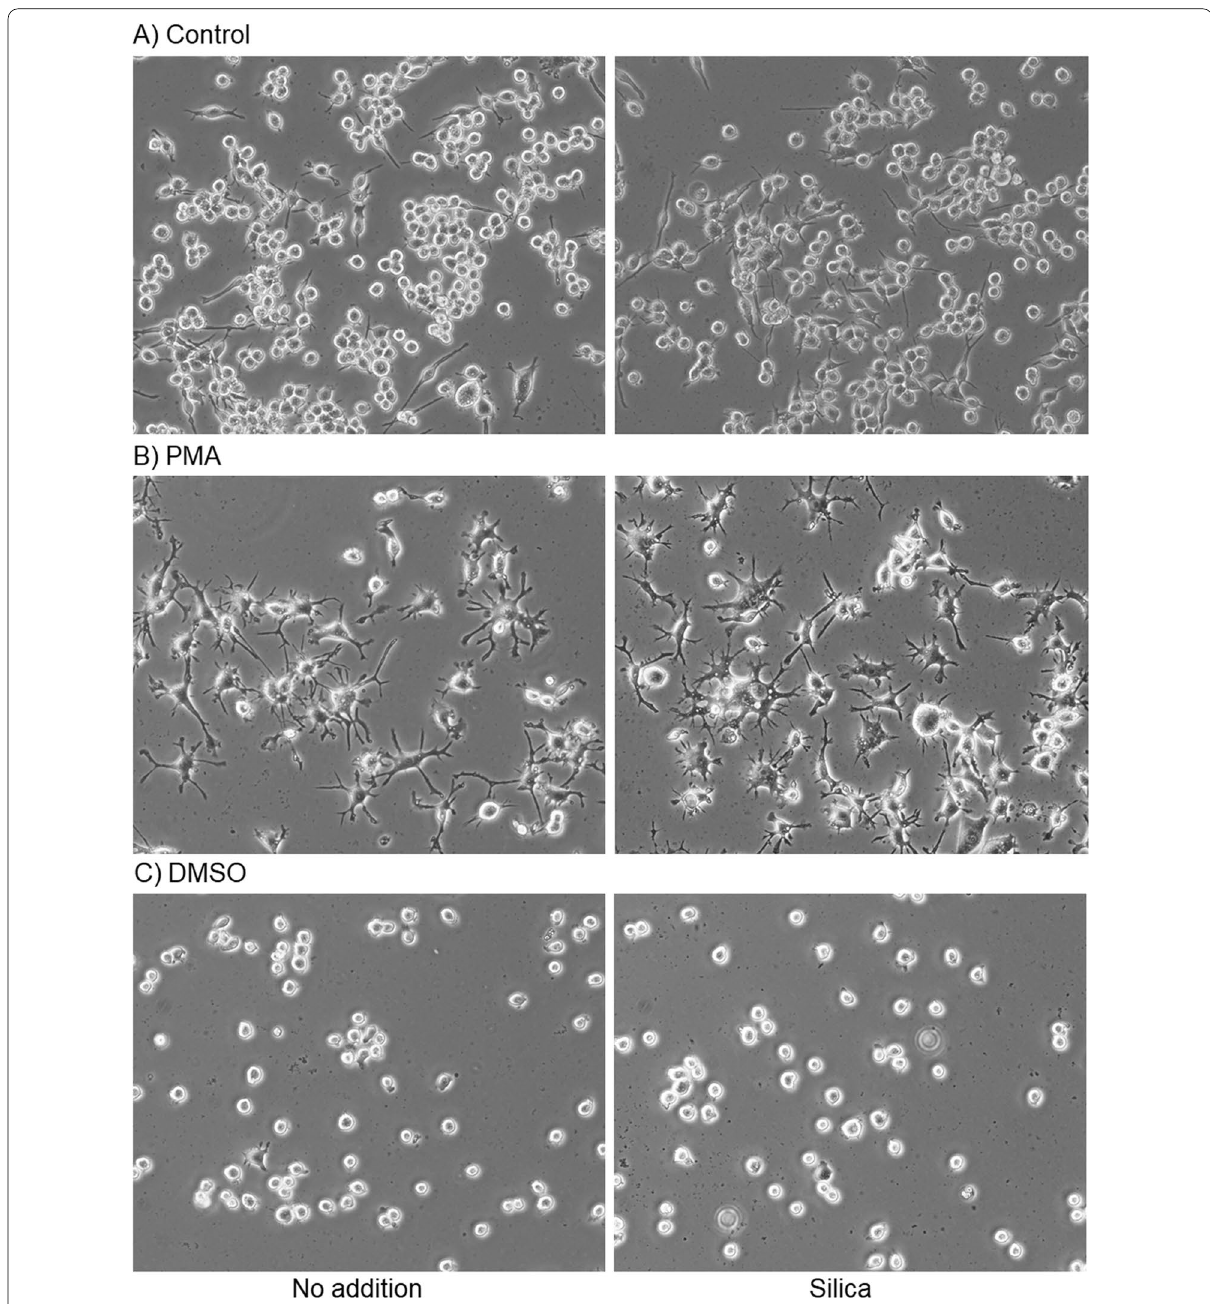
Fig. 3 Effects of silica microparticles (MPs) on cell morphology in control A and phorbol 12-myristate 13-acetate (PMA)- B and dimethyl sulfoxide (DMSO)-treated HL60 cells ( C ). These cells were simultaneously treated with silica MPs for 3 days and examined microscopically without fixation. Similar data were obtained from two additional independent experiments ( n =